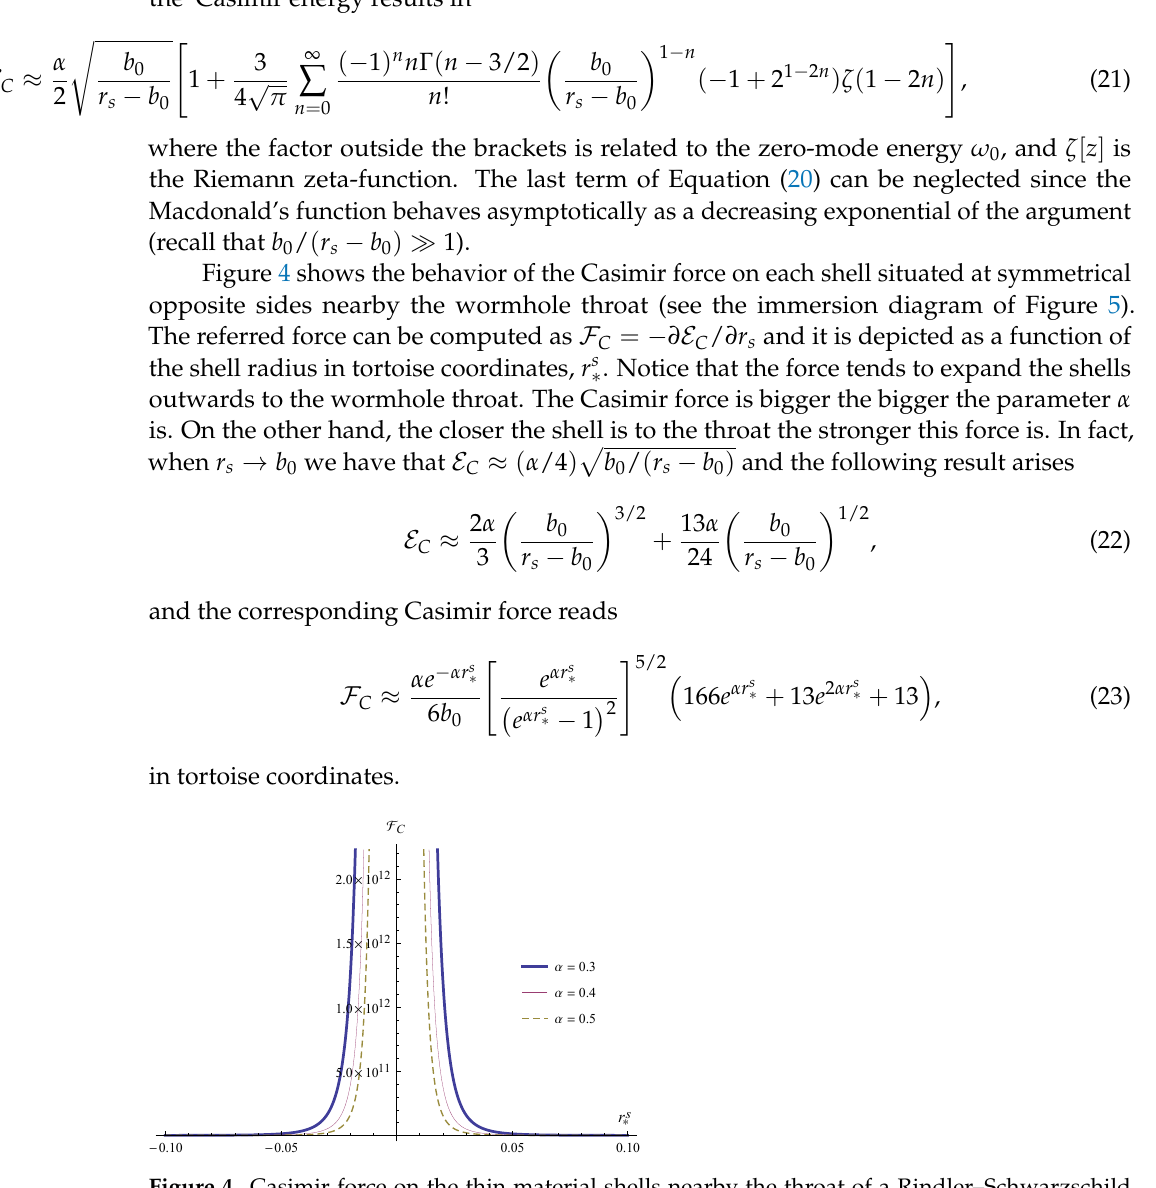
Figure 4. Casimir force on the thin material shells nearby the throat of a Rindler–Schwarzschild wormhole at its two opposite sides. The force is due to the vacuum of the massless scalar field obeying the Dirichlet boundary conditions, here depicted as a function of the shell radius in tortoise coordinates, r s ∗ , for some values of α and for b 0 = 1, in Planck units.